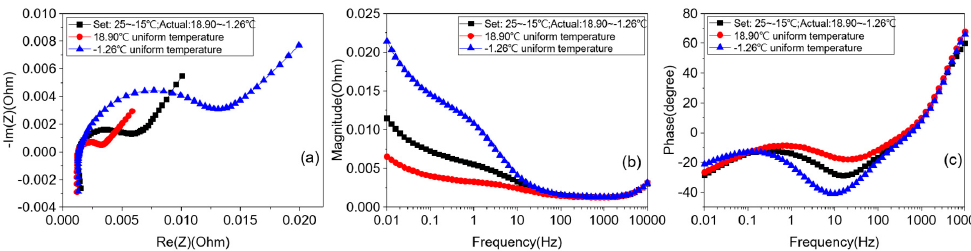
Figure 17. Comparison of the experimental results and lumped model impedance modified by the surface temperature: ( a ) EIS; ( b ) impedance magnitude; ( c ) impedance phase.